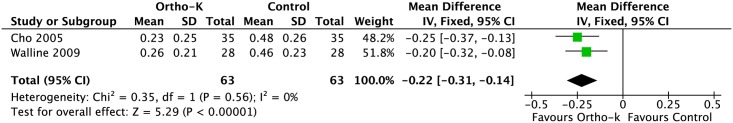
Forest plot of the treatment effect of orthokeratology on change in vitreous chamber depth.CI = confidence interval.